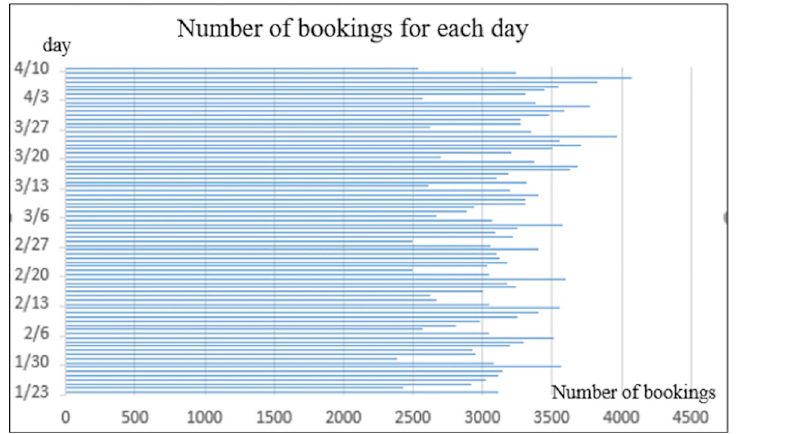
Fig 2. Number of bookings per